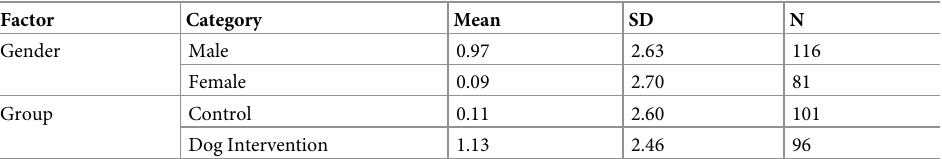
Table 7. Descriptive statistics for anxiety.